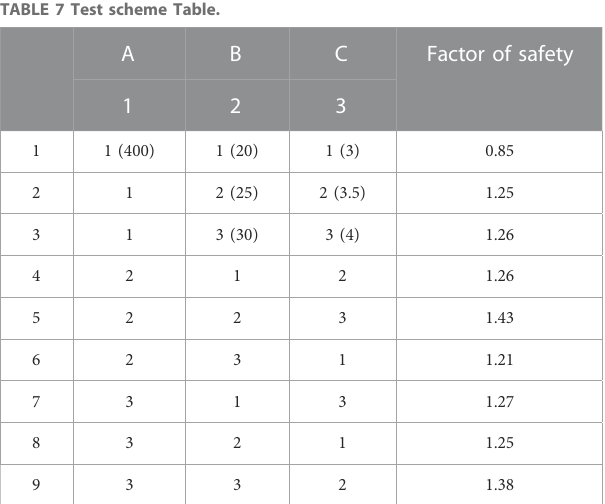
TABLE 7 Test scheme Table.